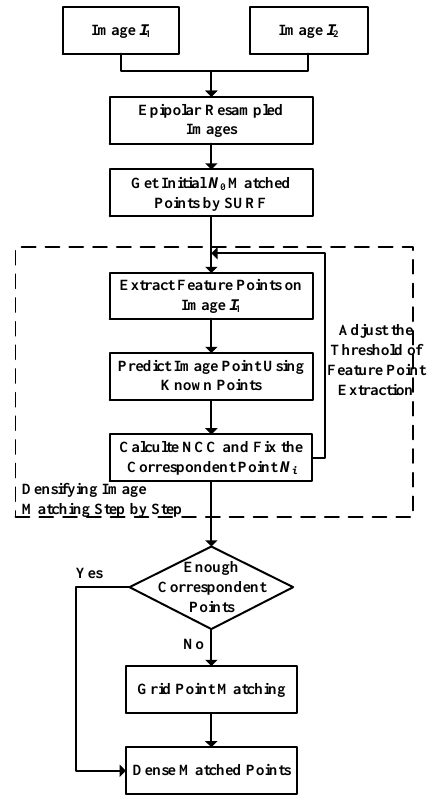
Figure 4. Procedure of P3M image